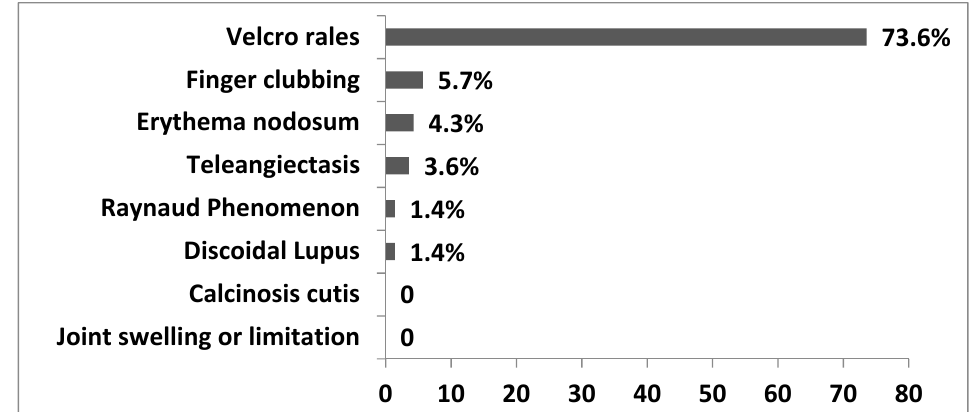
Figure 3. Observed symptoms in the clinical examination of uILD Patients. Data are presented as percentage of all uILD patients with reported symptoms. Multiple symptoms could be reported.